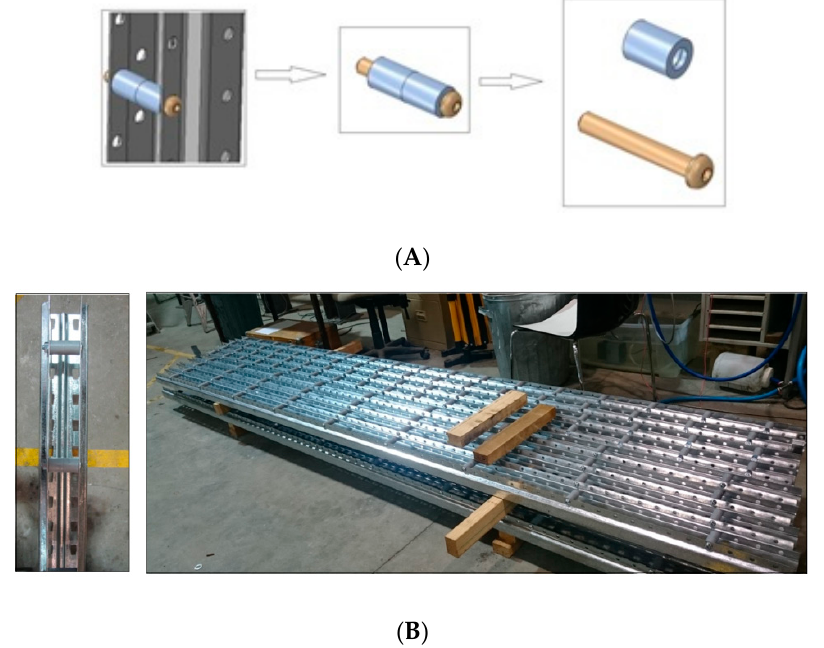
Figure 1. Reinforcement by bolts and spacers: ( A ) Schematic view; ( B ) Along the upright.